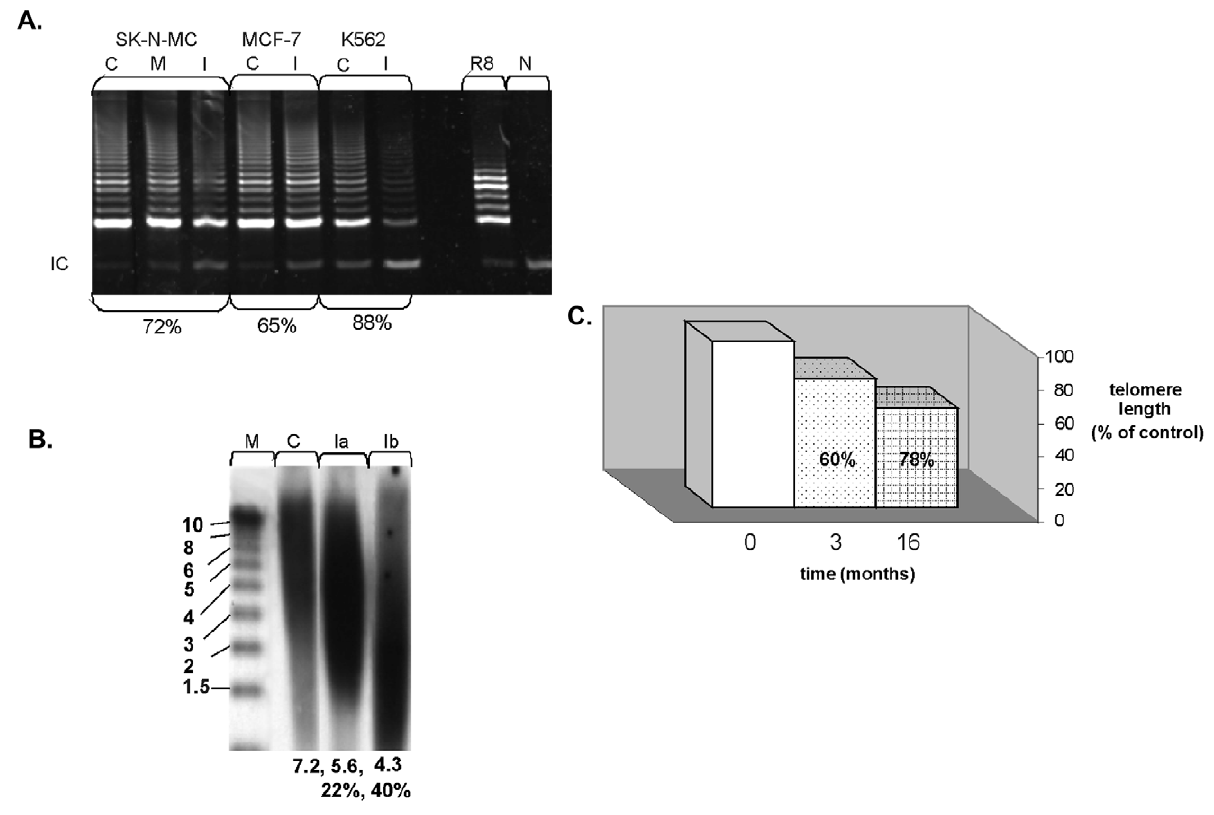
Figure 1. GRN163 inhibits telomerase activity in a sequence specific manner and shortens telomeres. a. SK-N-MC, MCF-7 and K562 were exposed to 5uM of GRN163. Telomerase activity was assessed by the TRAP assay after 24hours. C- control untreated cells, M- mismatch nonspecific scrambled oligo, I-telomerase inhibitor GRN163. R8- standard TRAP control, N- negative control with no cell extracts, IC- internal PCR control. The extent of telomerase inhibition is denoted in percentages below the lanes. b. SK-N-MC cells were continuously exposed to 5 m M of GRN163. Telomere length was measured by Southern blot. C- control untreated cells, Ia- telomere length of cells exposed to telomerase inhibitor for three months, Ib- telomere length of cells exposed to telomerase inhibitor for 16 months, M- molecular size marker. Mean telomere length is denoted below each lane, and the percent of telomere shortening is shown as well. c. Graphical presentation of the extent of telomere shortening after the exposure of SK-N- MC cells to GRN163 for 1 year as measured by Southern blot.